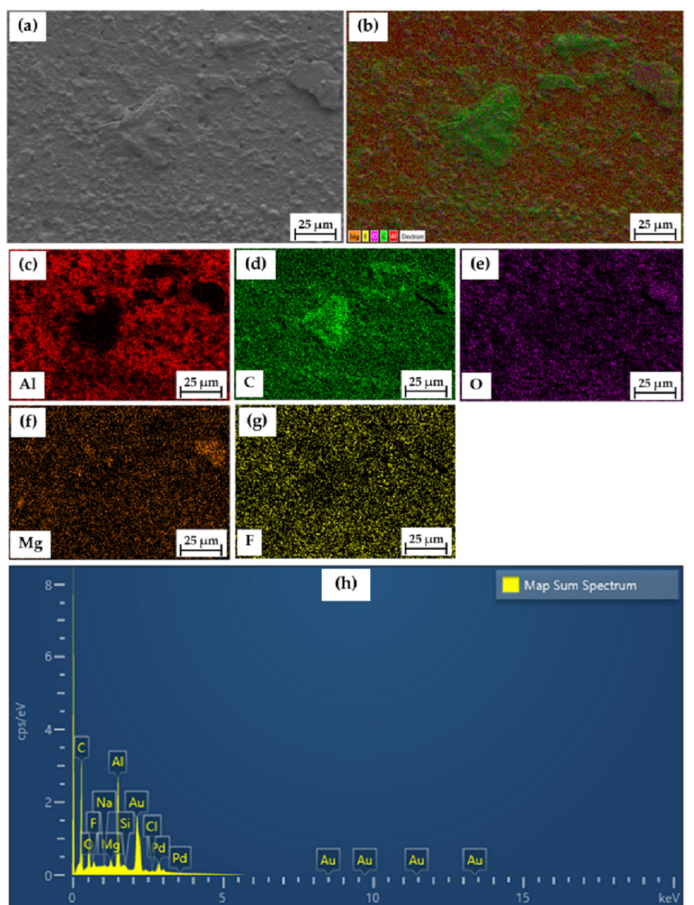
Figure 20. EDS analysis of welded joints: ( a ) SEM micrographs of SSM 5083; ( b ) element dispersion;